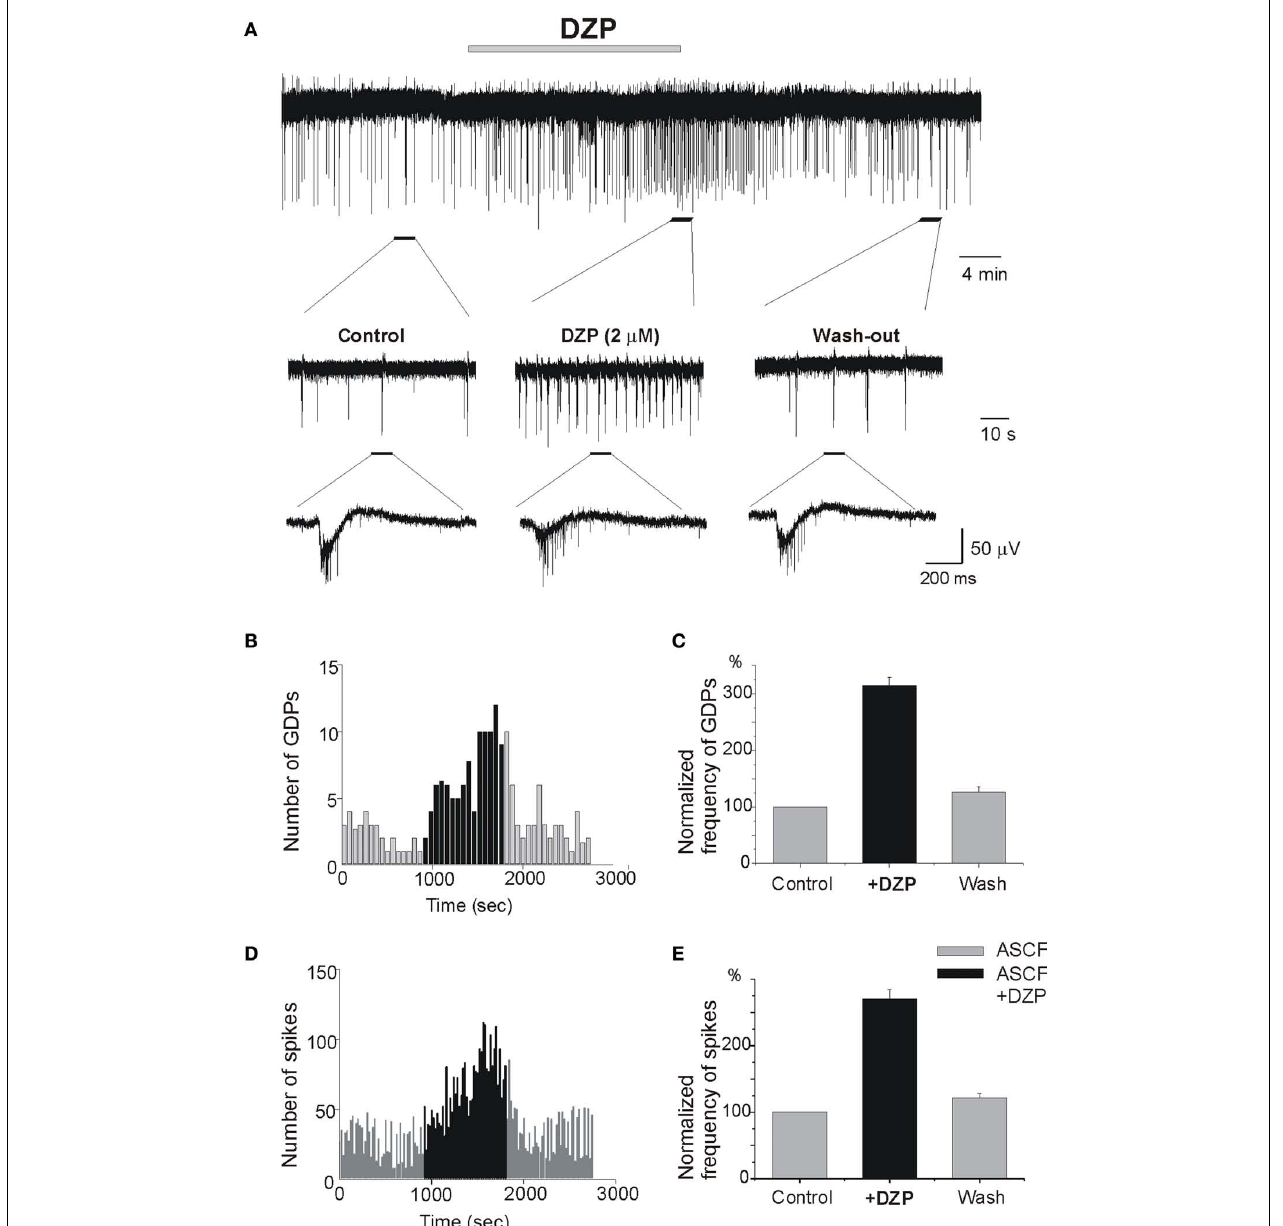
frequency of GDPs (B) and spikes (D) by DZP: (B–D) quantification of recorded GDPs and spikes from (A) , Bin = 20s. (C–E) Quantification of mean frequency of GDPs and spikes. DZP enhanced the frequency of GDPs (C) by 215.1 ± 13.6 ( p < 0.001, n = 14) and spikes (E) by 170 ± 14.8% ( p < 0.001, n =